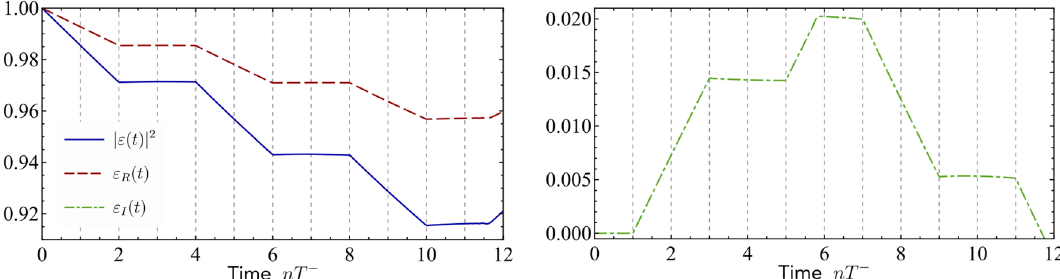
Figure 4. Evolution of the squared excitation amplitude and imaginary parts ε R ( t ) , ε I ( t ) , for N the decay is observed until the time t